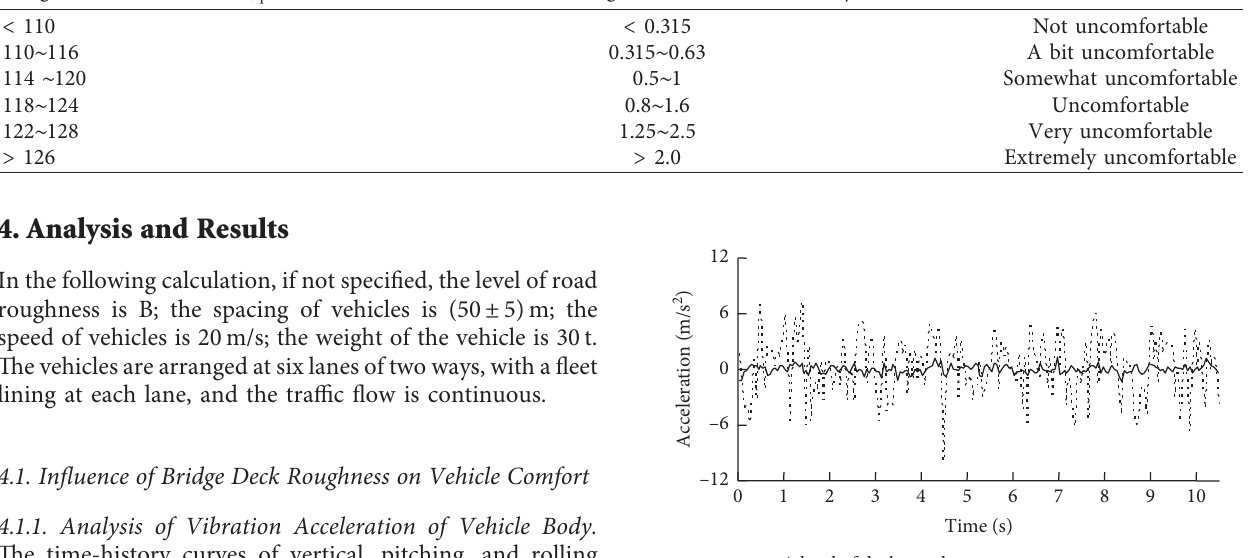
Table 1: The relationship among the ride comfort level, weighted vibration level, and total weighted acceleration RMS value. Weighted vibration level L eq (dB)